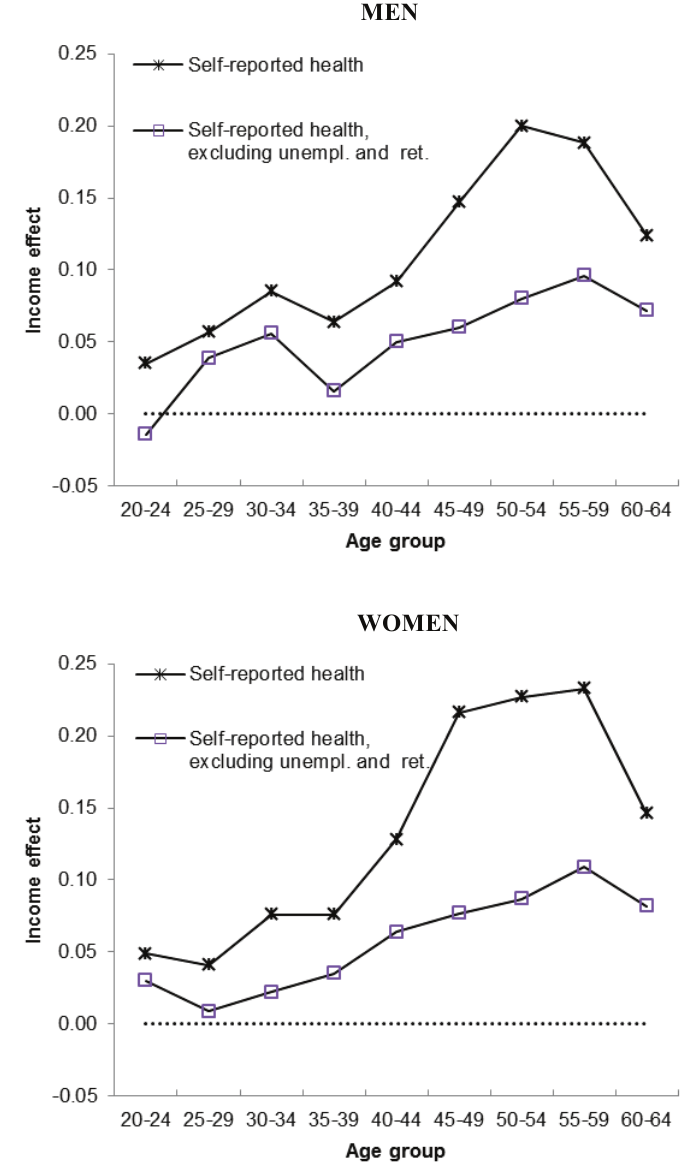
Fig. 7-8 Age variation in the relationship between self-reported health and income when excluding the unemployed, retired and